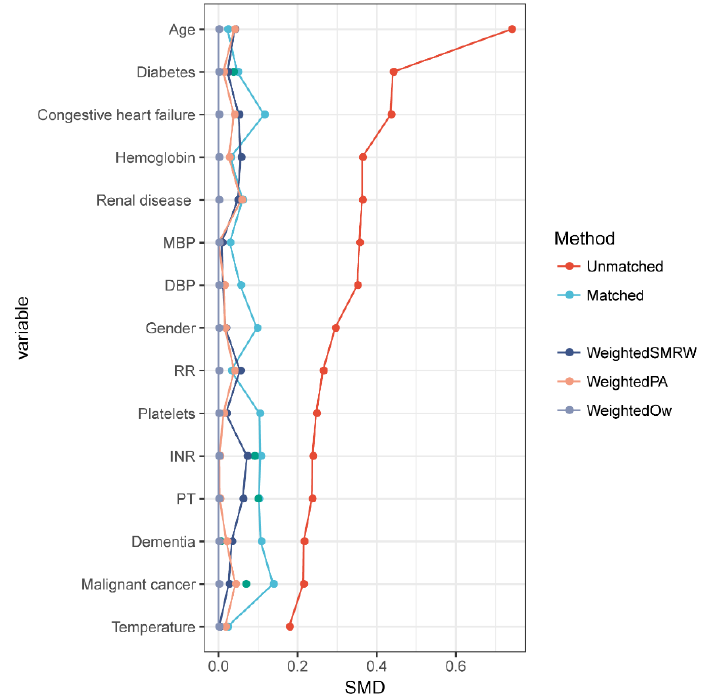
Figure 3. The results of matching. A standardized mean difference (SMD) was used to examine the degree of PSM. A threshold of less than 0.1 was considered acceptable. PSM, propensity score matching [19] ; weighted SMRW, weighted the standardized mortality ratio weighting [16]; weighted PA, weighted pairwise algorithmic [15]; weighted OW, weighted overlap weight [18] . MBP, mean blood pressure; DBP, diastolic blood pressure; RR, respiratory rate; INR, international normalized ratio; PT, prothrombin time.